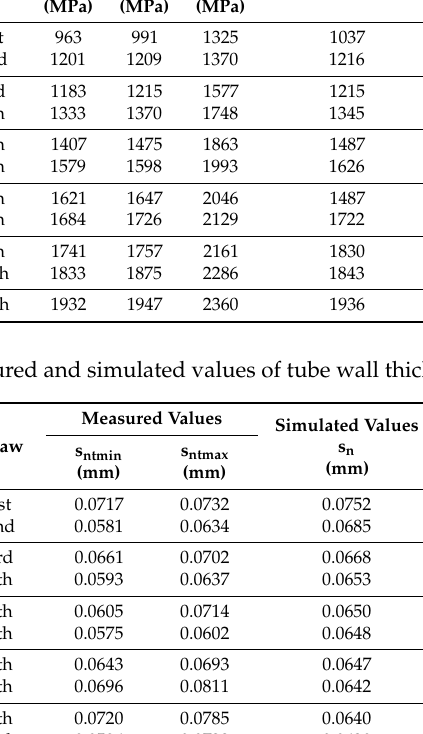
Table 6. Comparison table of calculated and simulated values of e ff ective stresses in the formed material. Calculated Values Draw